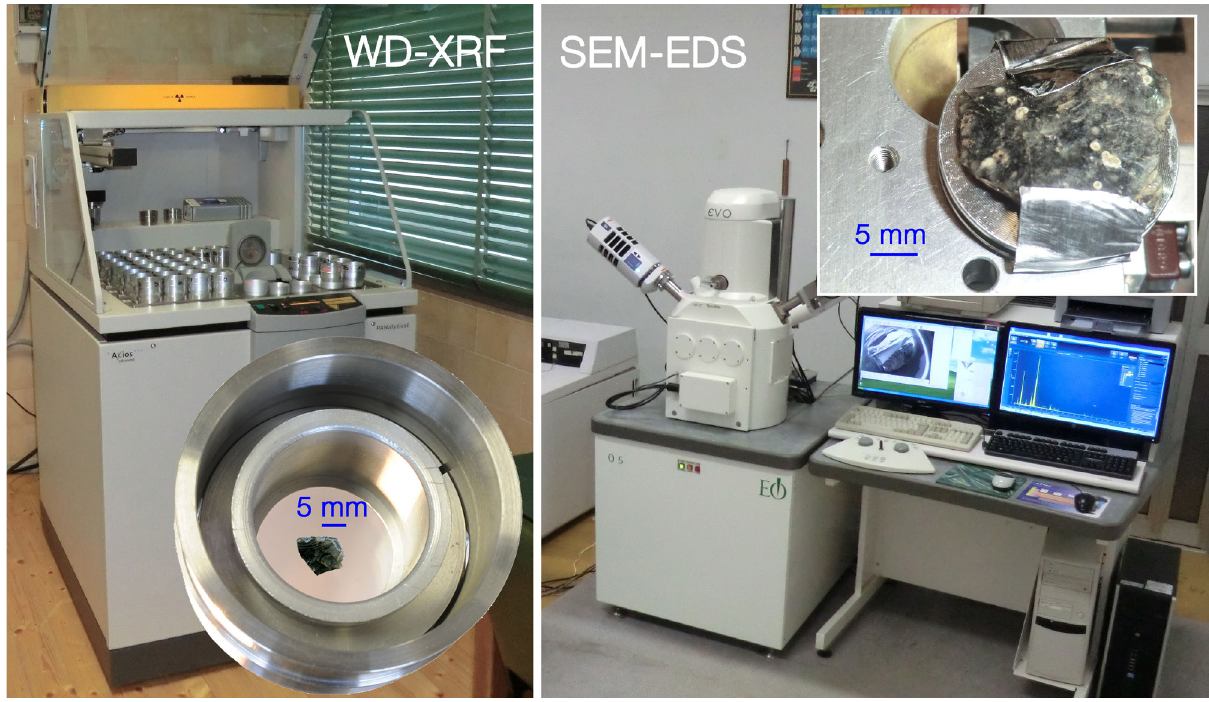
Figure 3: On the left side of the figure, the WD-XRF equipment used for chemical characterization of the obsidian samples and a detail of one sample holder closed at the bottom by a thin sheet of Mylar©, carrying in the center a very small obsidian artifact (in this figure the sample USFRA 101) which seems suspended in the air. On the right side of the figure the SEM-EDS used for glass microanalyses of the obsidian sample; in the inset a particular od the SEM sample holder with an obsidian sample (USFRA 4), whose surface was not sputtered with carbon film because particularly rich in spherulites: the specimen was fixed to the stub with adhesive aluminum conductive